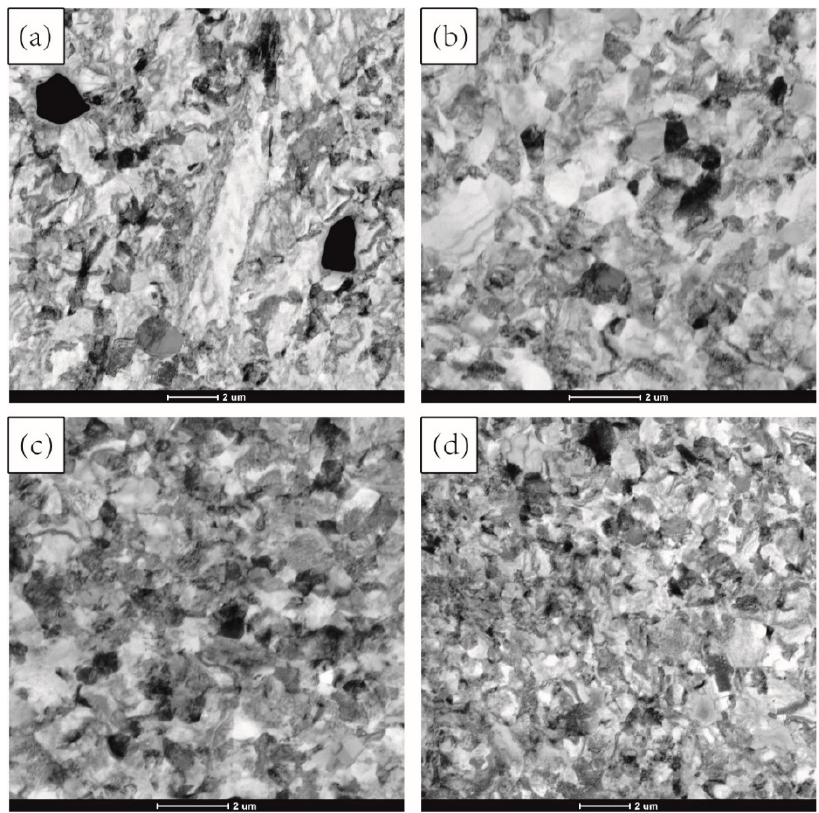
Figure 12. TEM image of TC4 alloy after MDIF: ( a ) one cycle; ( b ) two cycles; ( c ) three cycles; ( d ) four cycles.